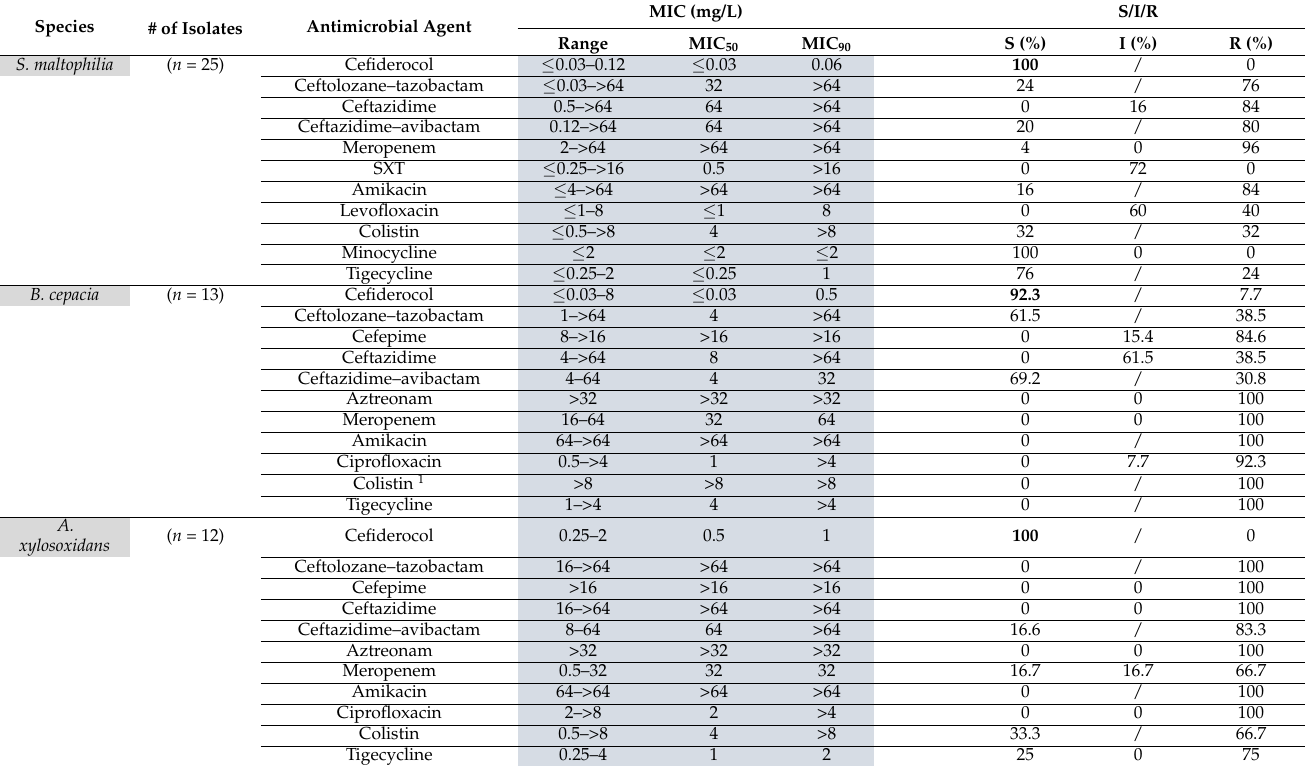
Table 4. In vitro activity of cefiderocol and comparators against Gram-negative pathogens isolated from hospitals in France and Belgium according to EUCAST